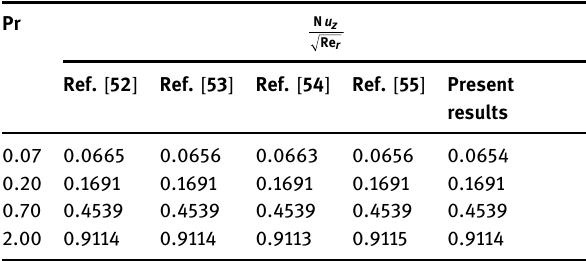
Table 1: Analysis of the present results with previously published